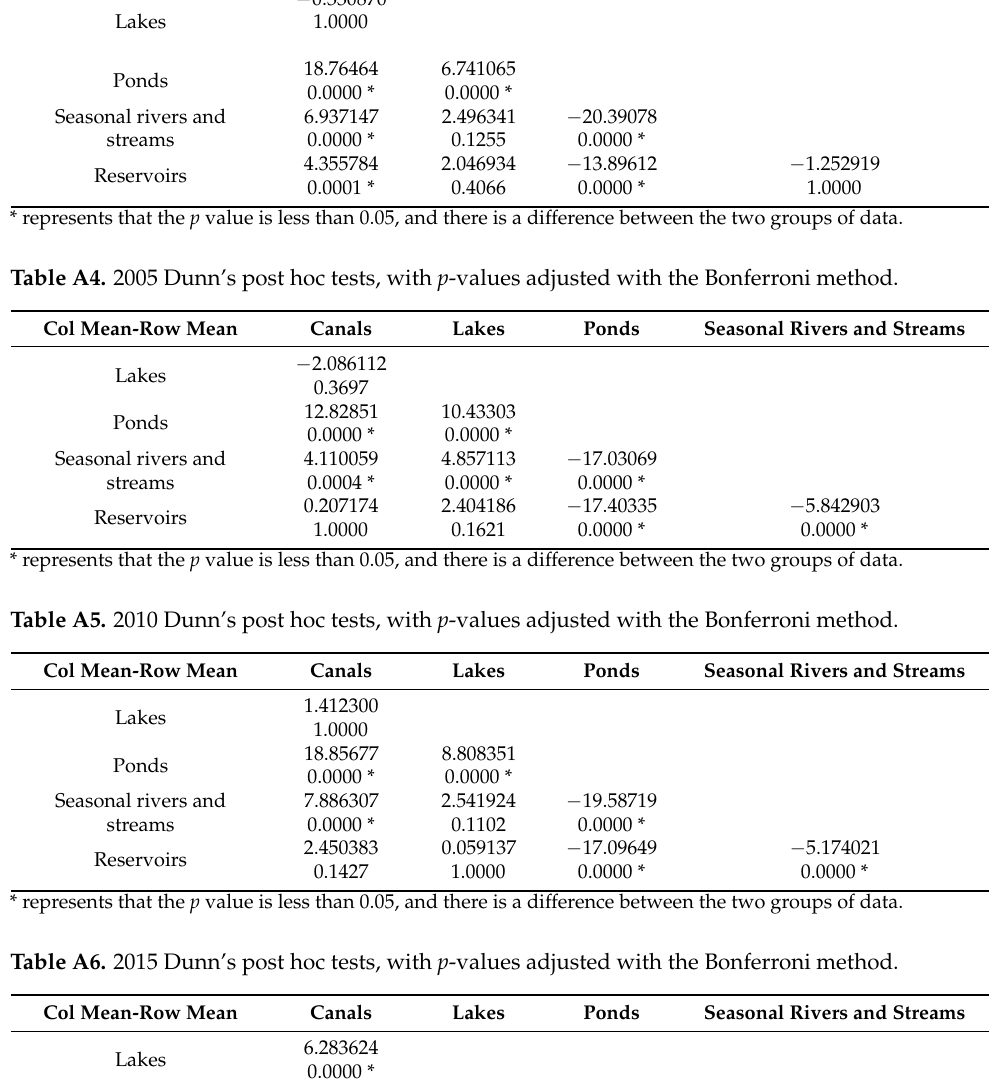
Table A3. 1995 Dunn’s post hoc tests, with p -values adjusted with the Bonferroni method. Col Mean-Row Mean